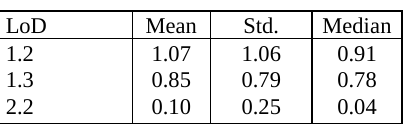
Table 1 . The median, mean and standard deviation of the RMS per LoD. Values in meters.